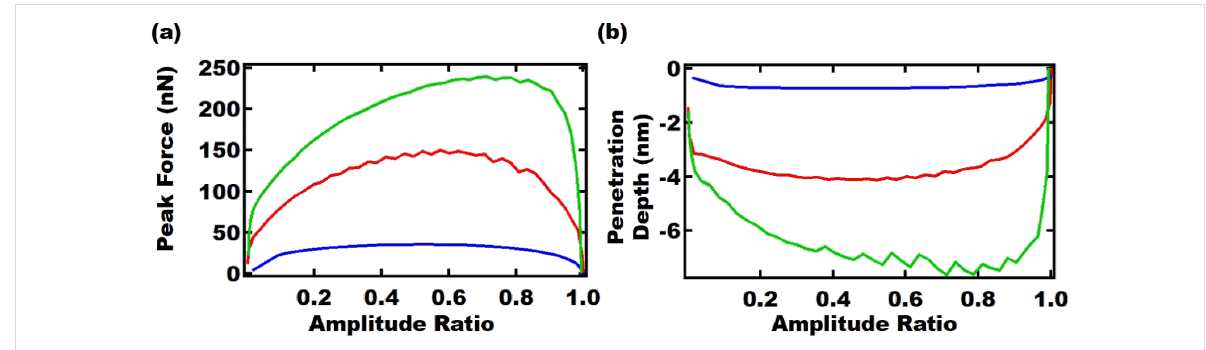
Figure 2: Numerical simulations corresponding to a parabolic AFM tip tapping on a polyisobutylene surface, described as a viscoelastic material con- taining multiple characteristic times using the generalized Maxwell model with the parameters of Table 1. The results show: (a) the peak tip–sample interaction force, and (b) the maximum indentation depth, with respect to amplitude setpoint ratio for AM-AFM using the first eigenmode (red line), AM-AFM using the second eigenmode (blue line), and bimodal AFM using the first two eigenmodes (green line). f 1 ≈ 45 kHz, f 2 ≈ 280 kHz, k 1 ≈ 5.80 N/m, k 2 ≈ 210 N/m, A 1 ≈ 350 nm, A 2 ≈ 11 nm. The parameters are selected based on the experimental values found by tuning the cantilever as discussed in the next section. The amplitudes provided are the free oscillation amplitudes.